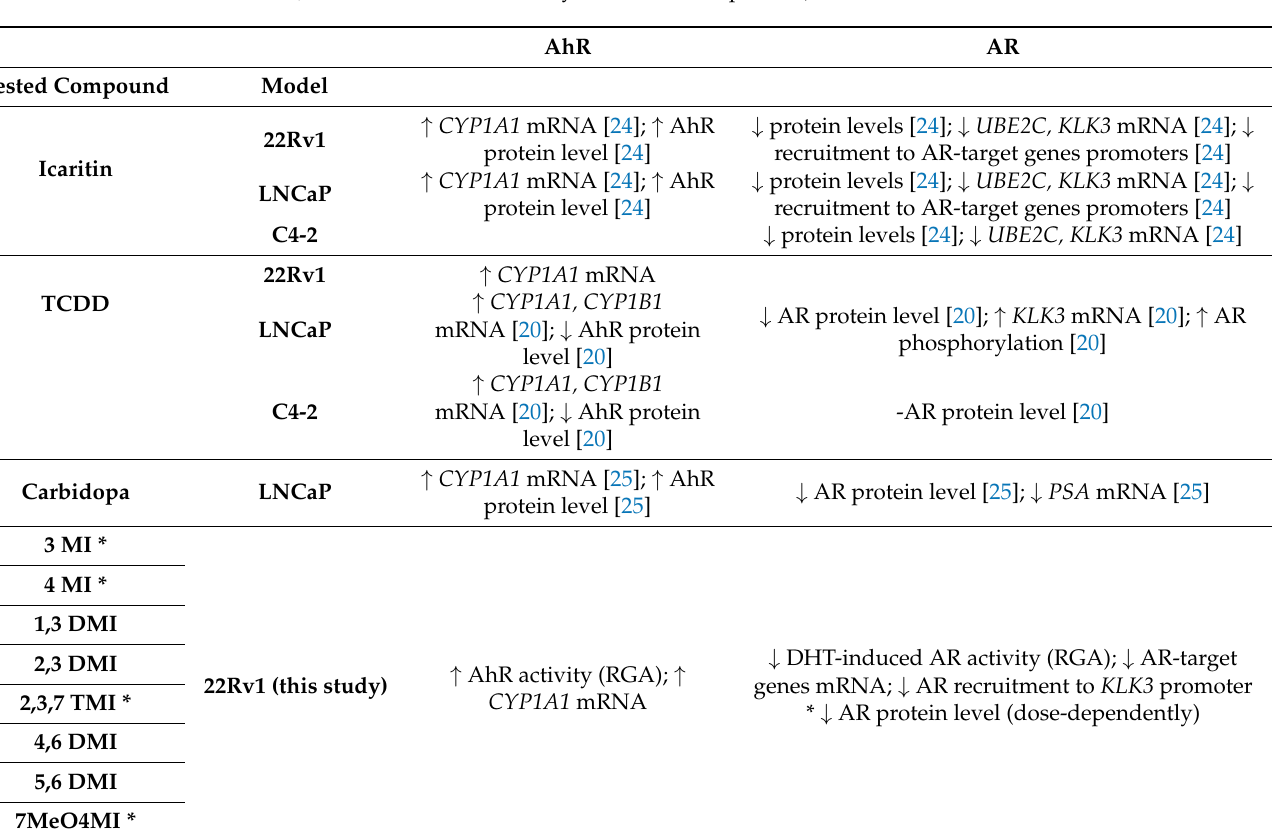
Table 2. Comparison of the effects of different compounds on AhR and AR receptors ( ↑ increase, ↓ decrease, - no effect; * only for certain compounds). AhR